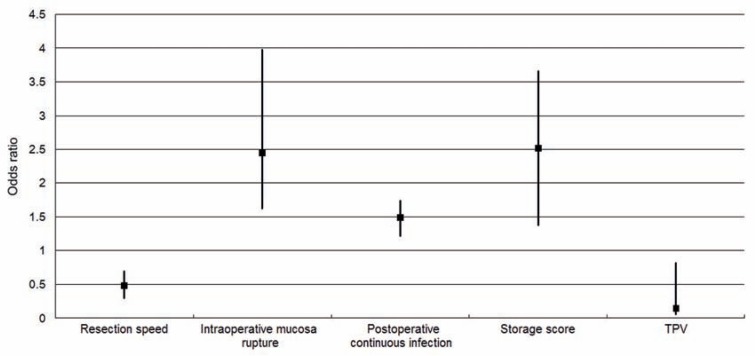
Odds ratio value of independent risk/protective factors about postoperative urethral stricture and bladder neck contracture.